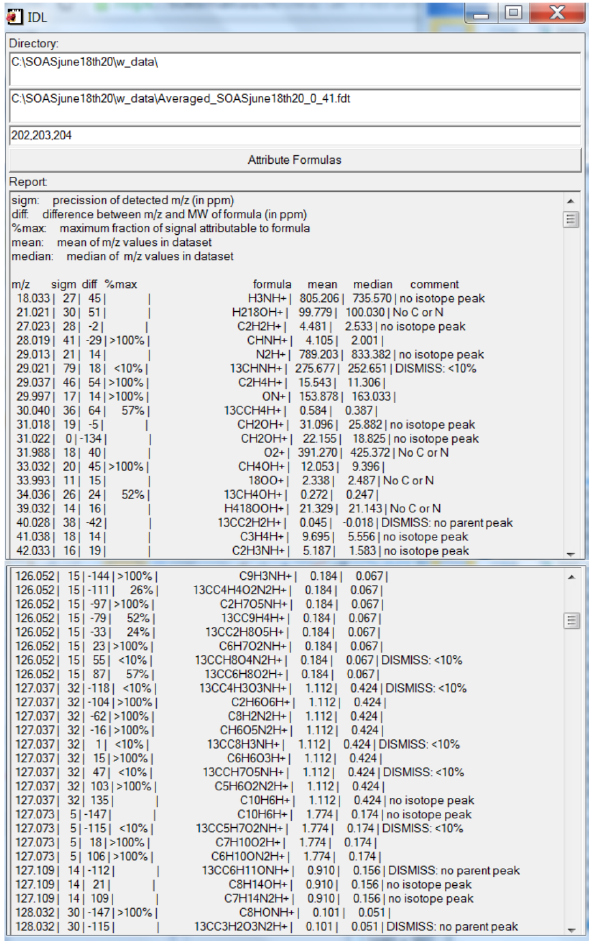
Figure B4. The Attribute Formulas tool window and fractions of the report produced from a 3-day period during the SOAS campaign. The full report is also saved in a report